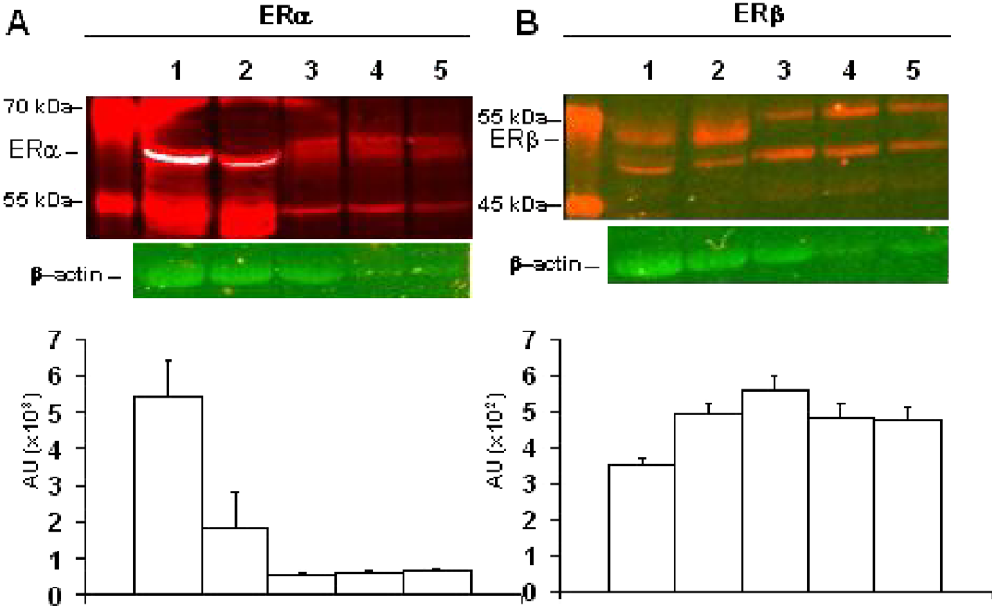
Fig. 3. Western blotting (upper panels) and QRT-PCR (lower panels) of ER α (A) and ER β (B). Note : lane 1 – SPN tissue, lane 2 – pancreatic normal tissue, lanes 3–5 – SPNC at the 1st, 4th and 5th culture passage, respectively. QRT-PCR results are expressed in arbitrary units (AU, mean value ±